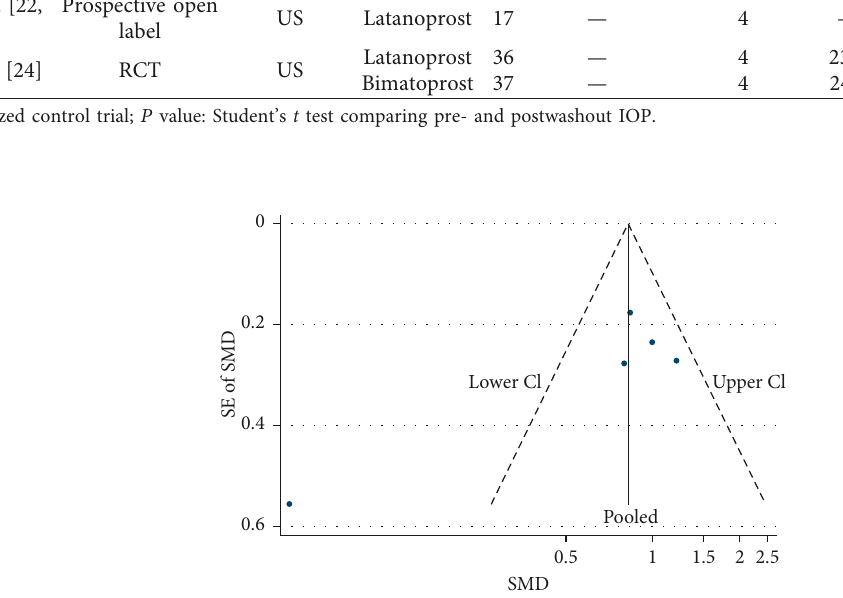
Figure 4: Visual inspection of funnel plot for both pre- and postwashout IOP (Figure 4) did not reveal any asymmetry.